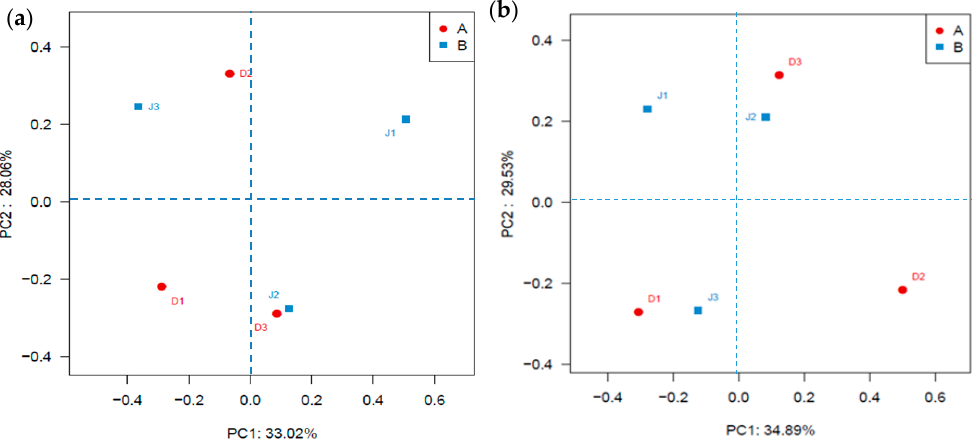
Figure 4. Community analysis based on PCoA on the Bra—Curtis distances of bacteria. ( a ) Bacterial genes; ( b ) Archaeal genes.